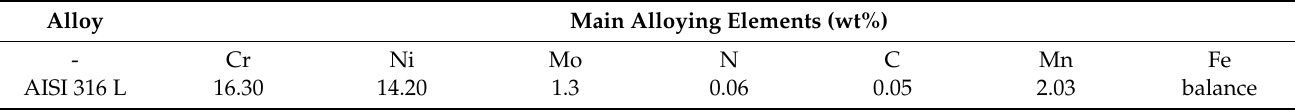
Table 1. Composition of AISI 316 L